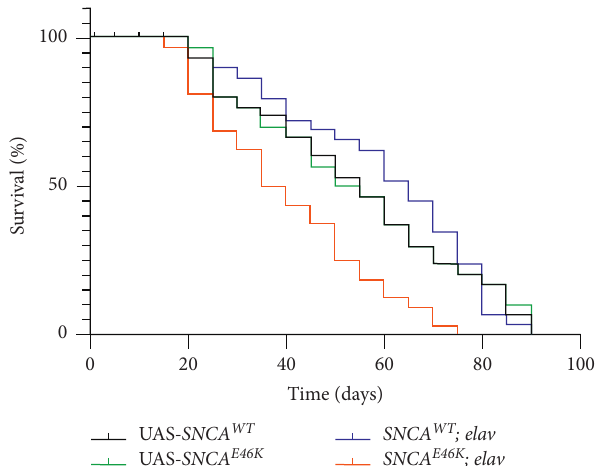
Figure 5: SNCA E46K expressing PD model flies live shorter lives. 360 one-day-old adult flies of each genotype were assayed for longevity. Statistical analysis using the Mantel–Cox log rank test revealed a significant decline in the maximum and median lifespan of the transgenic insects ( p < 0 .